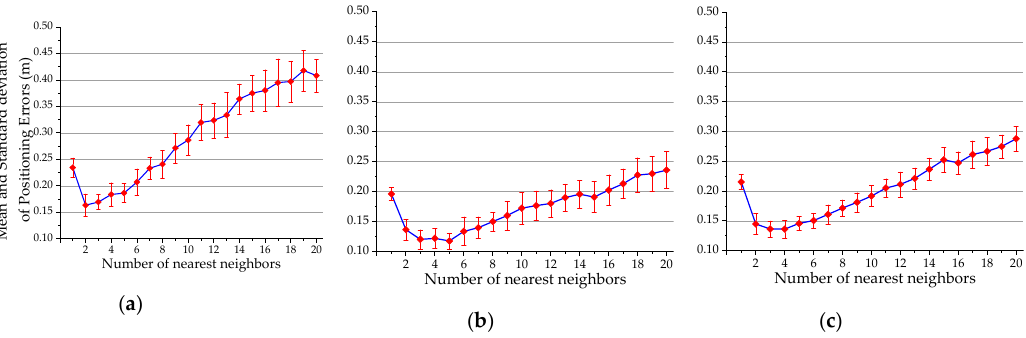
Figure 12. The mean and standard deviation of positioning errors vs. number of nearest neighbors by: ( a ) whole floor, ( b ) center area, and ( c ) edge area.